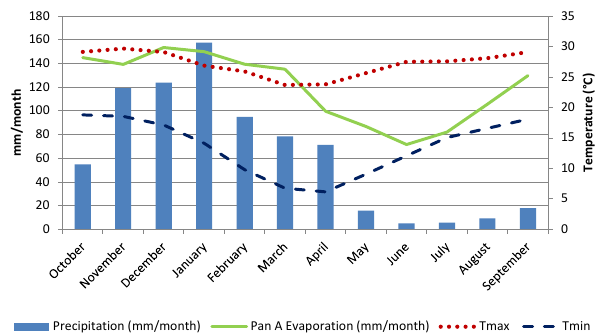
Figure 3. Average monthly precipitation, pan-A evaporation (from stations X1E006, X1E007, Barberton and Malelane), and maximum and minimum temperatures at Barberton station from 2001 to